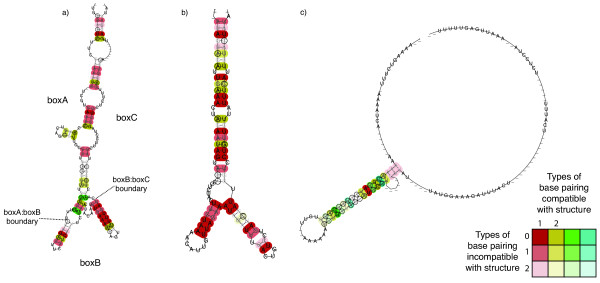
Predicted repeat sequence secondary structures. These images represent the predicted secondary structures of transcribed forms of the repeat sequence families: a) BOX, b) RUP and c) SPRITE. The structures were generated from an alignment of 30 sequences from the S. pneumoniae ATCC 700669 genome in each case; only BOX elements with a canonical A1B1C1 structure were used to produce the structure in a). The boundaries between the different subsequences are marked on the image. Base pairings are coloured according to their conservation in the alignment: the bolder the colour, the more strongly conserved the pairing of the bases, with different colours indicating different numbers of compatible interactions at equivalent sites in the structure (see key).